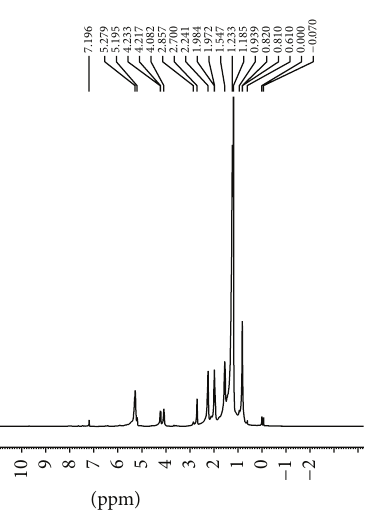
Figure 1: 1 H NMR of C. fistula lipid extracts.